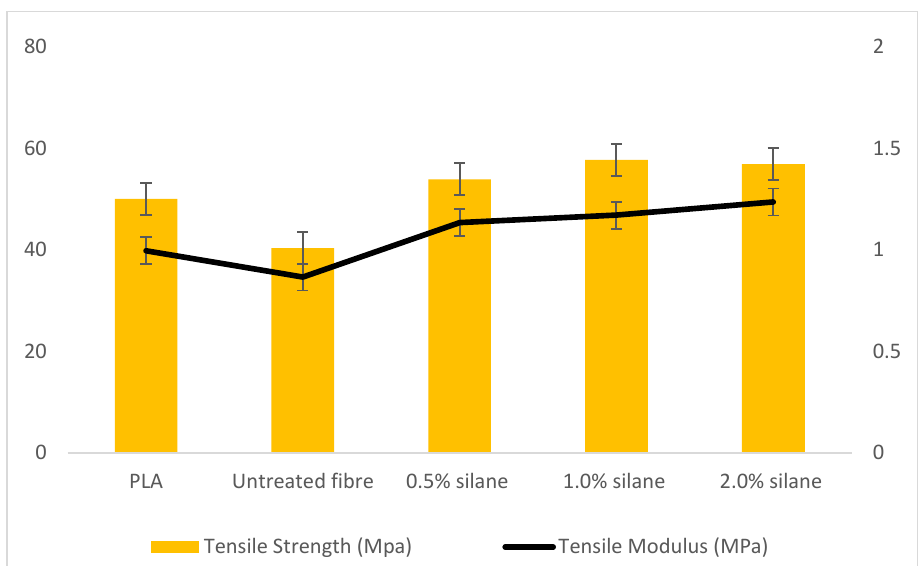
Figure 5. Results of composites tensile strength, MPa, and tensile modulus, MPa.